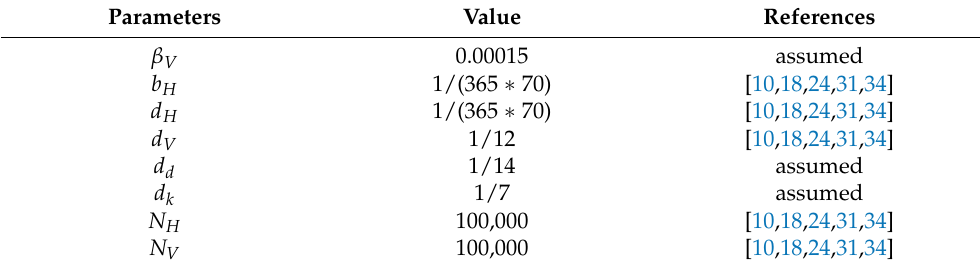
Table 3. Parameter and their values